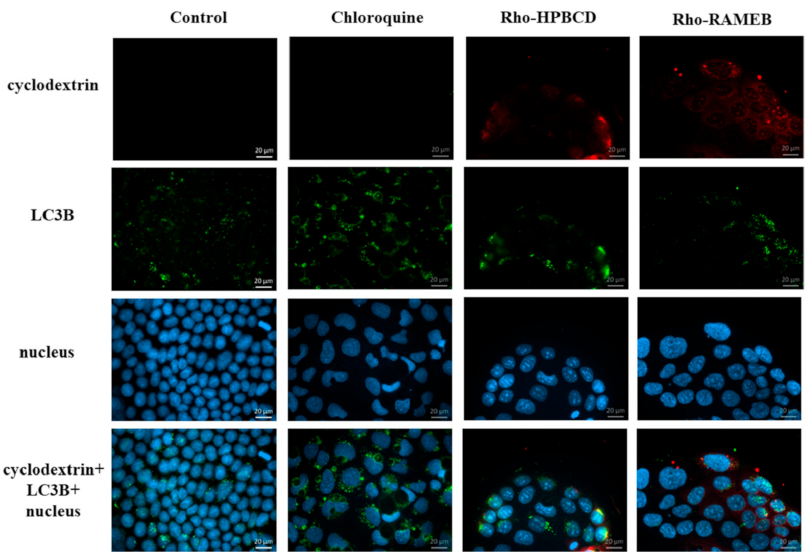
Figure 6. Fluorescence microscopic images of Caco-2 cells containing autophagosomes. After Rho- HPBCD and Rho-RAMEB treatments the presence of autophagosomes is similar to the control sample. After chloroquine treatment autophagosomes, labeling was more intensive.